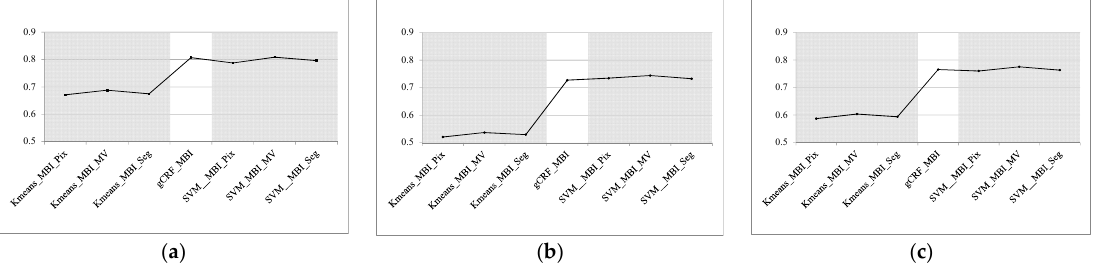
Figure 19. Quantitative evaluation of the MBI-based methods using the Pléiades image: ( a ) recall; ( b ) precision; and ( c ) F -value.